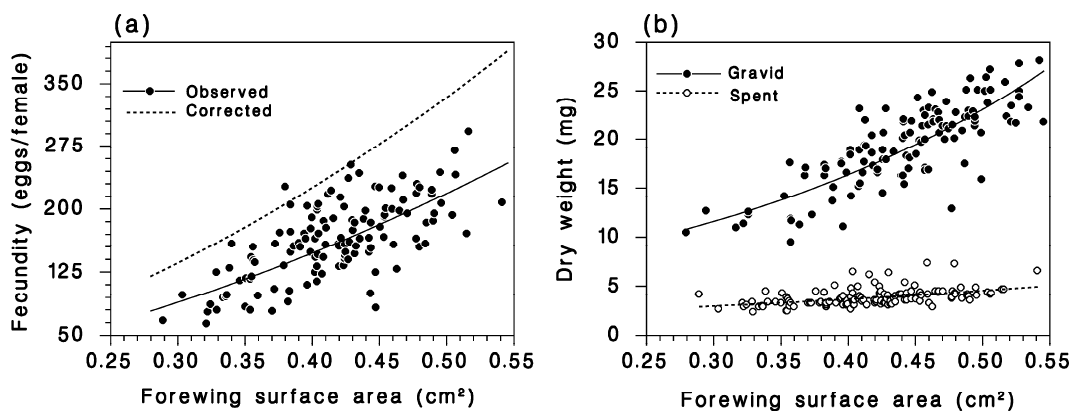
Figure 1. ( a ) Relationship between forewing surface area and lifetime fecundity among females collected as pupae on balsam fir foliage (64% defoliation) at Lac des Huit-Milles, 1989–1990 (solid line: Equation (1); dotted line: after correction for defoliation using Equation (2)). ( b ) Relationship between forewing surface area and dry weight of fully gravid and spent females (lines: Equation (3)), pupae collected at Lac des Huit-Milles, 1989–1990.